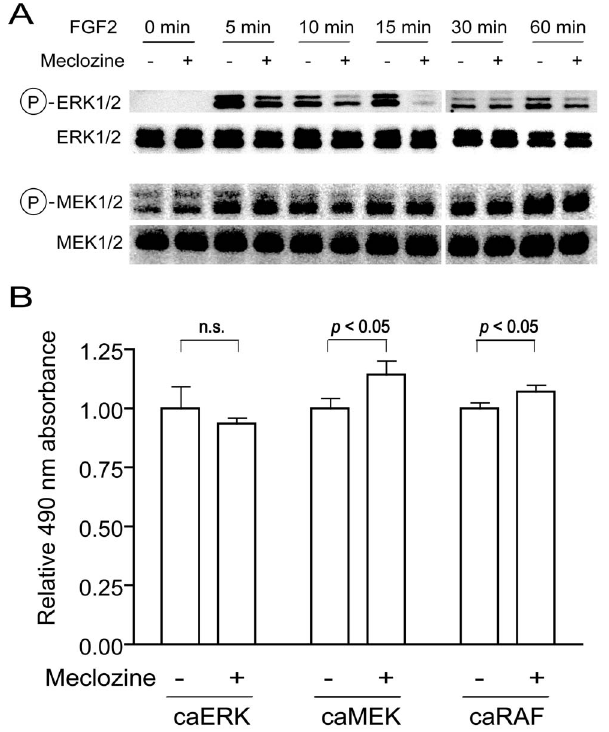
Figure 5. Meclozine attenuates FGFR3-mediated ERK phos- phorylation in FGF2-treated RCS cells. ( A ) RCS cells were pretreated with 20 m M meclozine for 30 minutes before adding 5 ng/ ml FGF2 and the levels of ERK and MEK phosphorylation were determined by Western blotting. As a loading control, the membranes were reprobed with antibodies against MEK and ERK. Meclozine suppressed FGF2-mediated ERK phosphorylation but not MEK phos- phorylation after adding FGF2. ( B ) RCS cells were infected by lentivirus expressing constitutively active (ca) ERK, MEK, and RAF mutants. Cells were treated with 20 m M meclozine and their proliferation potencies were quantified using the MTS assay. The 490-nm absorbance was normalized to that without meclozine and the mean and SD are presented ( n =3). Meclozine rescued caMEK- and caRAF-mediated growth arrest, but had no effect on caERK-mediated growth arrest.